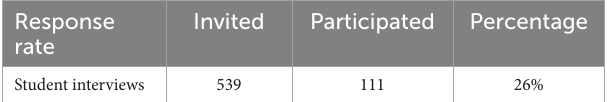
TABLE 6 Response rate of student